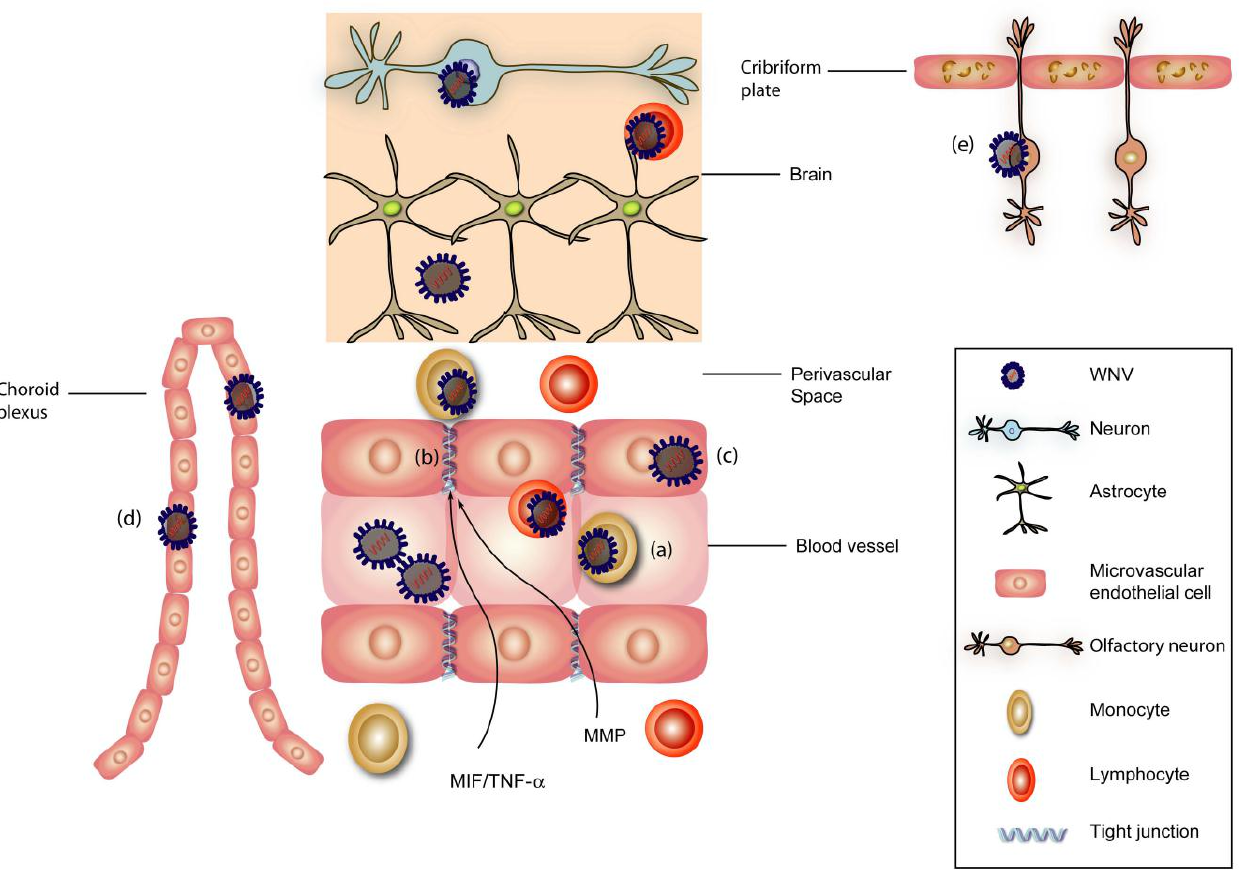
Figure 1. Mechanism of neuroinvasion of West Nile virus (WNV). WNV may enter the central nervous system (CNS) via multiple mechanisms including axonal retrograde transport along peripheral neurons into the spinal cord or hematogenous transport across the blood-brain barrier (BBB). Spinal cord entry is believed to result in interneuron spread to motor neuron cell bodies within the anterior horn of the spinal cord and lead to flaccid paralysis. The possible routes of virus entry across the BBB include ( a ) “Trojan horse” model; intracellular transport within macrophages or neutrophils, ( b ) loss of integrity of the BBB; cytokine-mediated (TNF-α, MIF) or matrix metalloproteinases disruption of tight junctions and basement membranes; ( c ) direct infection of brain microvascular endothelial cells with basolateral spread of the virus; ( d ) infection of choroid plexus epithelial cells; or ( e ) direct infection of olfactory neurons adjacent to the cribriform